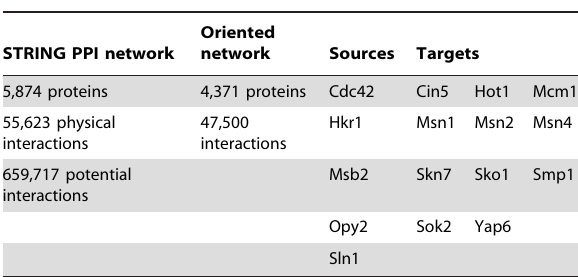
algorithm for the S HORTCUTS -X objective function, which attempts